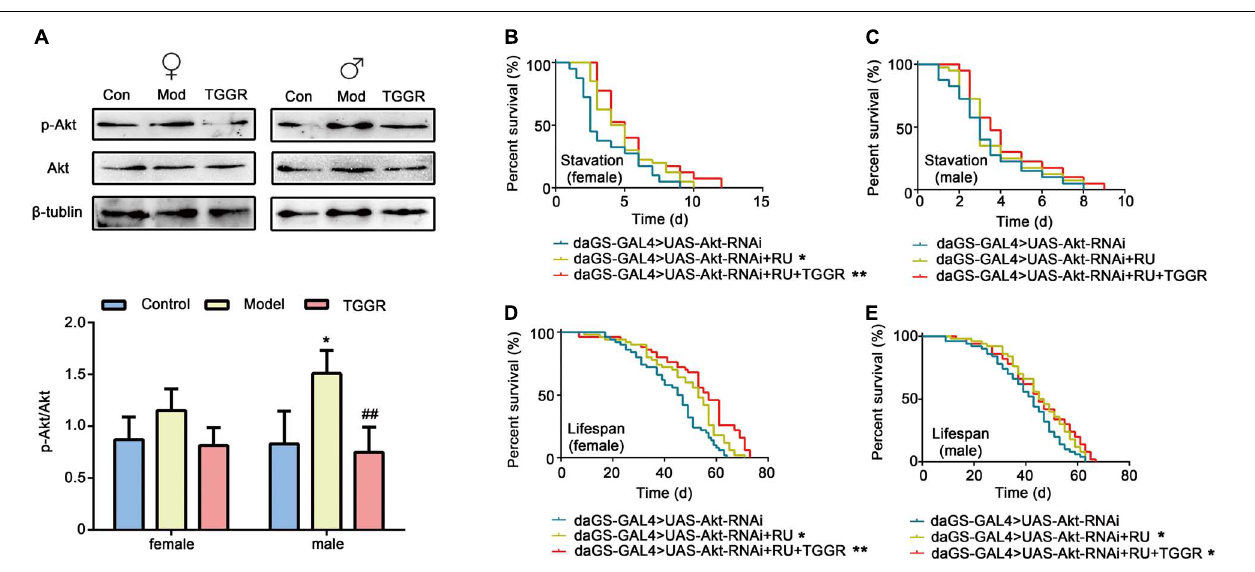
FIGURE 8 | TGGR-mediated longevity is influenced by Akt, a component of the insulin pathway. (A) TGGR decreased the level of p-Akt ( N = 50 flies per condition, two-tailed unpaired t -test). (B,C) Effects of Akt knockdown on starvation resistance effects in flies; (D,E) changes in lifespan of Akt knockdown flies [ N = 60 flies per condition, Log-rank (Mantel-Cox) test]. “Control” was 7-day-old flies, “Model” was 40-day-old flies, and “TGGR” was 40-day-old flies with TGGR (5 mg/mL) treatment. * p < 0.05, ** p < 0.01 vs. the control; ## p < 0.01 vs. the